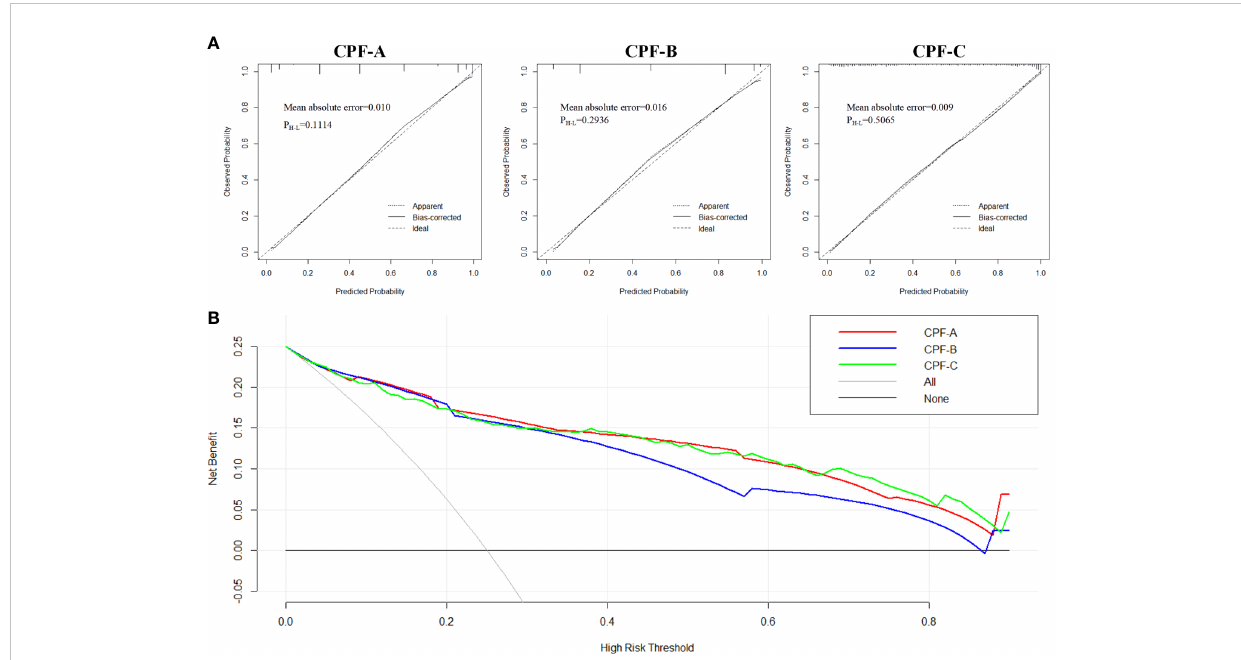
FIGURE 5 The evaluation of CPF-A, CPF-B, and CPF-C in the internal test samples. (A) Calibration curves of high-risk patients for GBC predicted by CPF-A, CPF-B, and CPF-C. (B) Decision curves of CPF-A, CPF-B, and CPF-C.